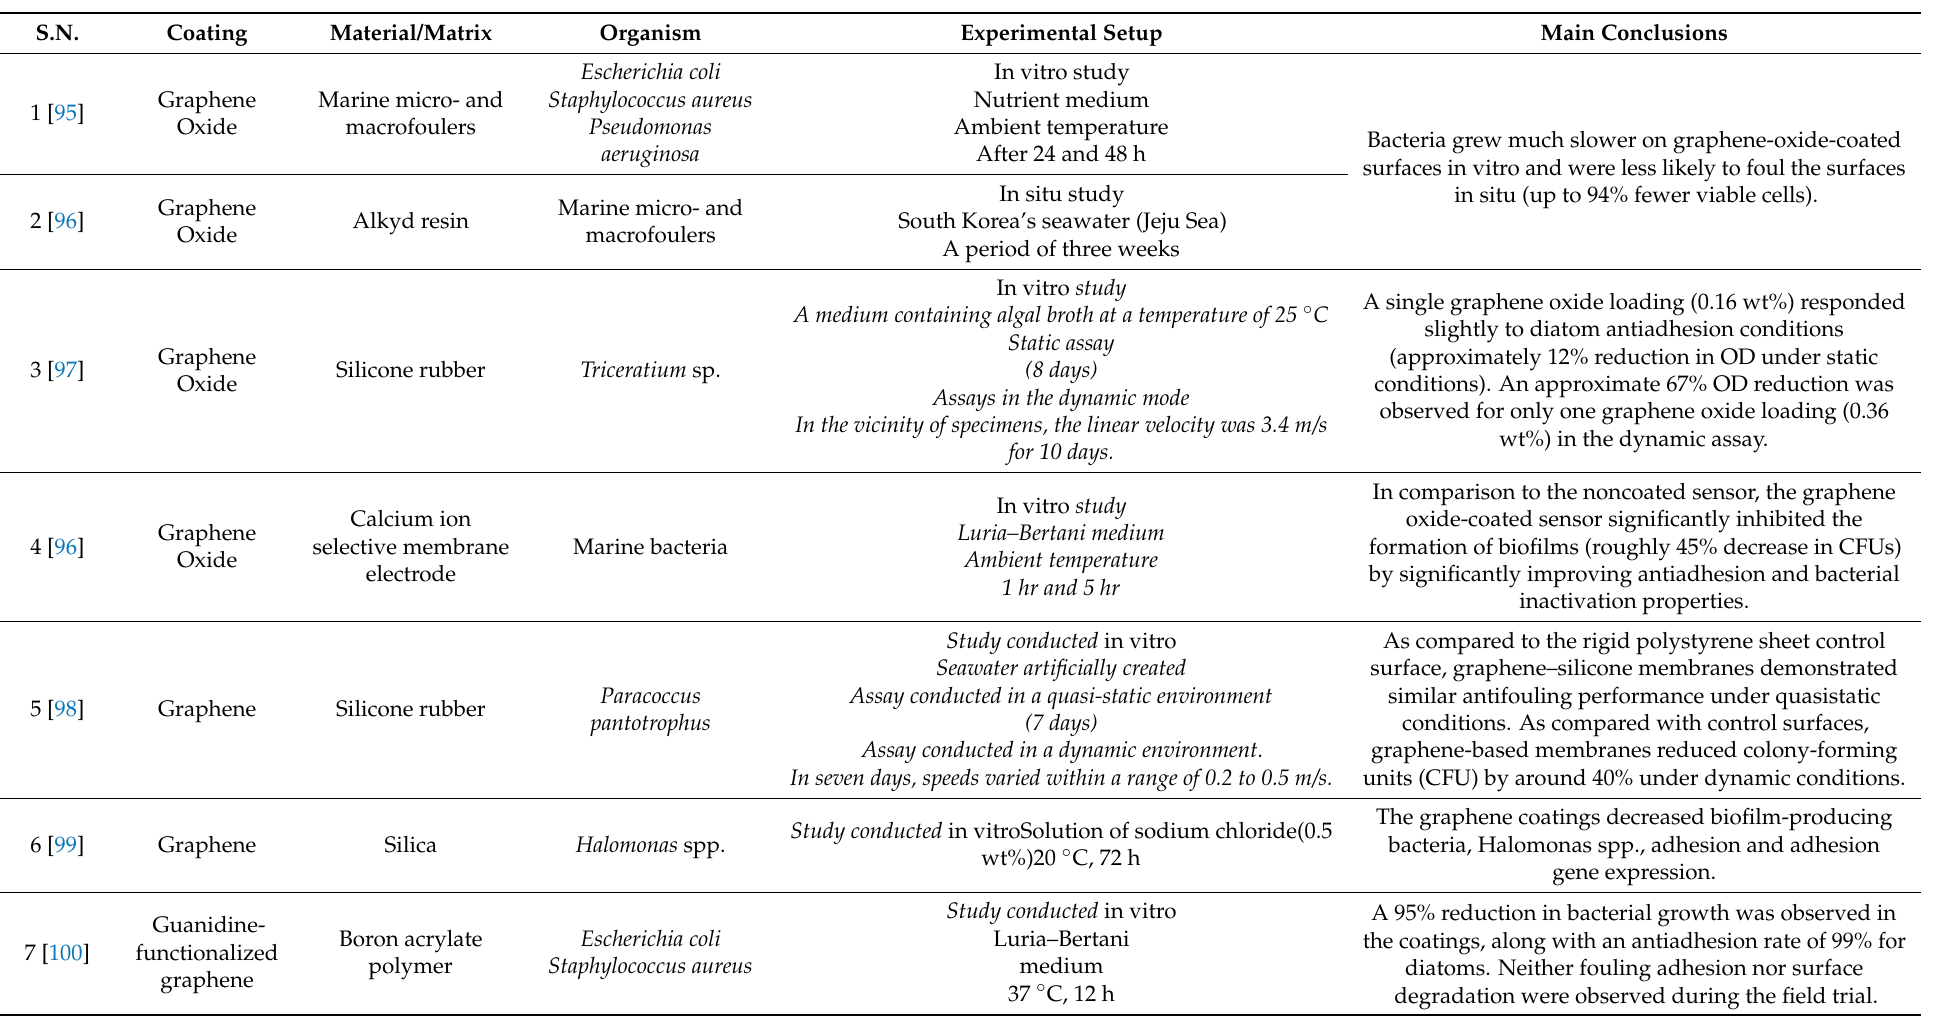
Table 3. A summary of the fouling resistance of polymeric membranes using GO-based composites, is provided below.